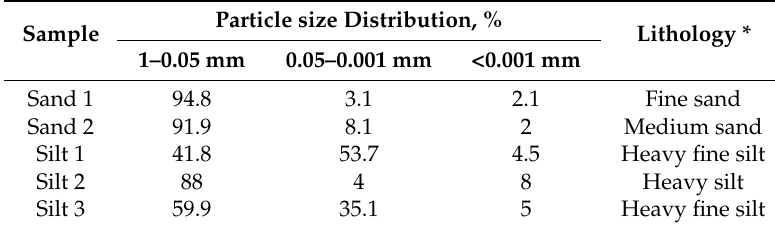
Table 2. Particle size